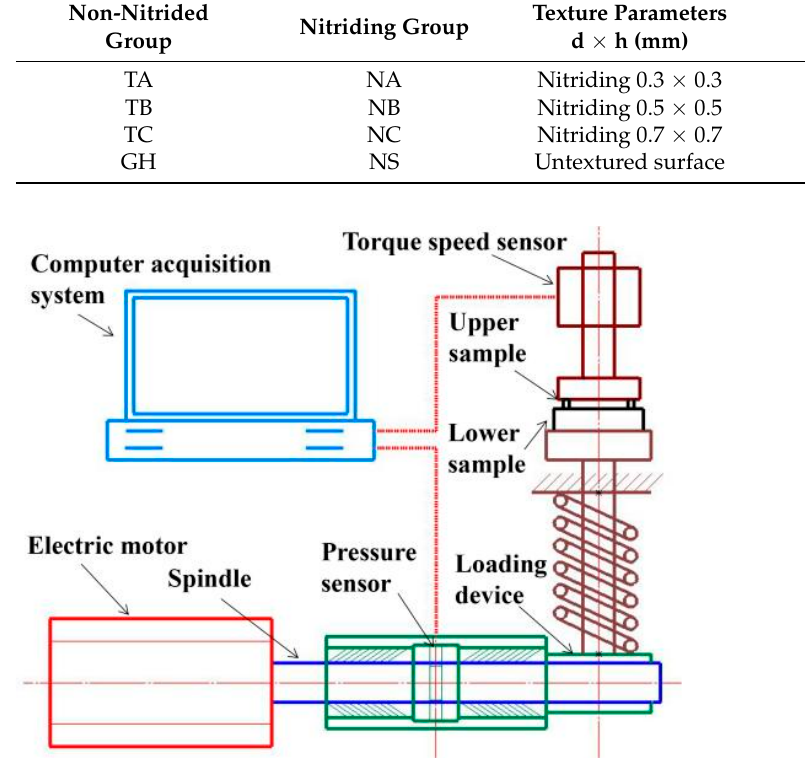
Figure 2. Working principle of MMW-1A vertical universal friction and wear testing machine.